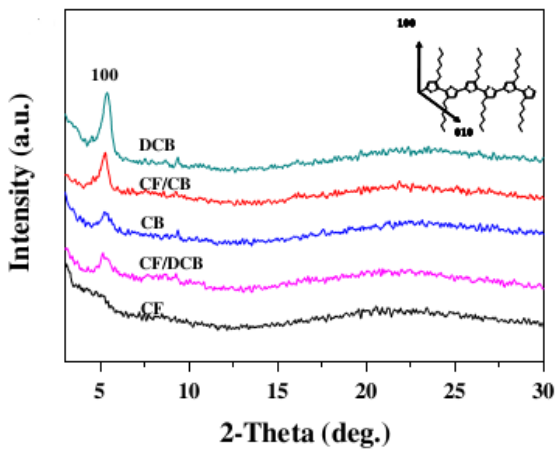
Figure 4. High-boiling solvent, dichlorobenzene (DCB), displayed increased intensity at 2 θ ≈ 5.2. Reprinted with permission from Elsevier